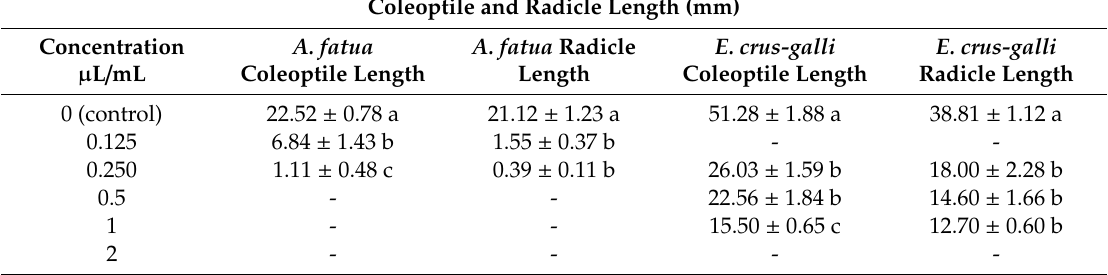
Table 6. Phytotoxic e ff ects of T. capitata EO (TC4) on Amaranthus retroflexus , Portulaca oleracea , Avena fatua and Echinochloa crus-galli coleoptile and radical